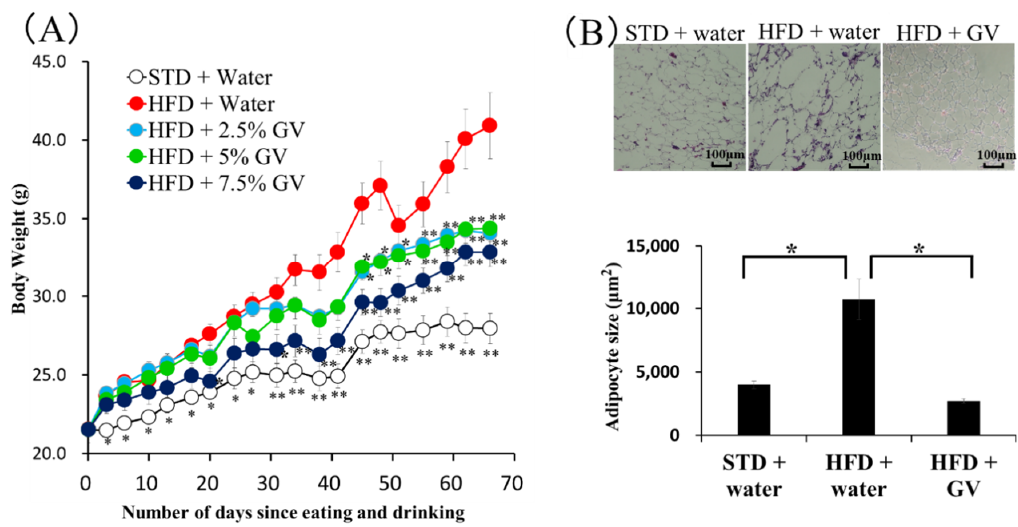
Figure 1. Effect of ginkgo vinegar on high-fat diet (HFD)-induced body fat gain in mice. Mice were fed either standard chow (STD) or a HFD with drinking water that contained 0%, 2.5%, 5.0%, or 7.5% ginkgo vinegar (GV) for 10 weeks. ( A ) Changes in the body weight of mice are illustrated. Data are the mean ± SD ( n = 5). * p < 0.05, ** p < 0.01 vs. HFD. ( B ) Sections from epididymal adipose tissues were obtained from mice fed either a STD or HFD with drinking water that contained 0% (plain water) or 5.0% GV for 10 weeks. For quantitative analysis, tissues were stained with hematoxylin/eosin (HE), and the cell areas were evaluated from 4 random fields that contained 50–60 cells. Data represent the mean ± SD (n = 5). * p < 0.05.